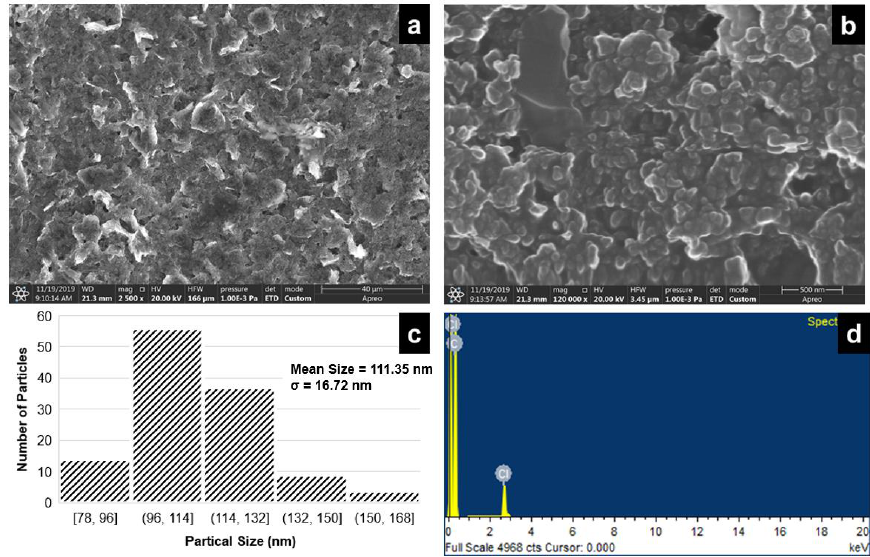
Figure 4. SEM image of inkjet-printed carbon ink at a magnification scale corresponding to ( a ) 40 µm, ( b ) 500 nm, ( c ) particle size distribution plot (mean particle size = 111.35 nm and standard deviation, σ = 16.72 nm) and ( d ) EDX analysis.